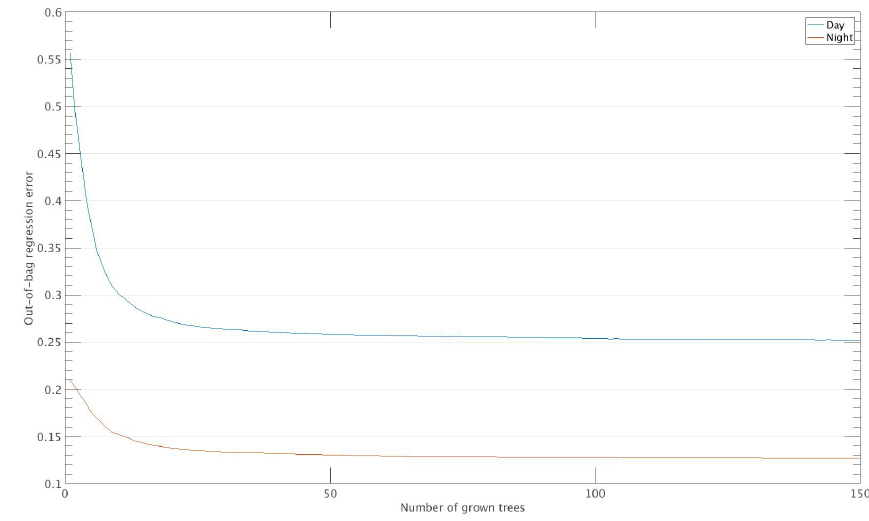
Figure B1. Out-of-bag error over the number of grown regression trees for day (blue line) and night (orange line).